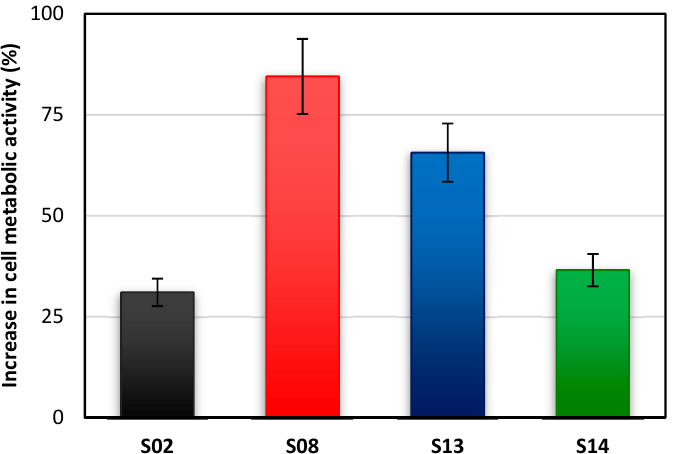
Figure 7. Changes in the metabolic activity of the Lactobacillus sp. 2675 cells exposed for 24 h to emulsion samples.